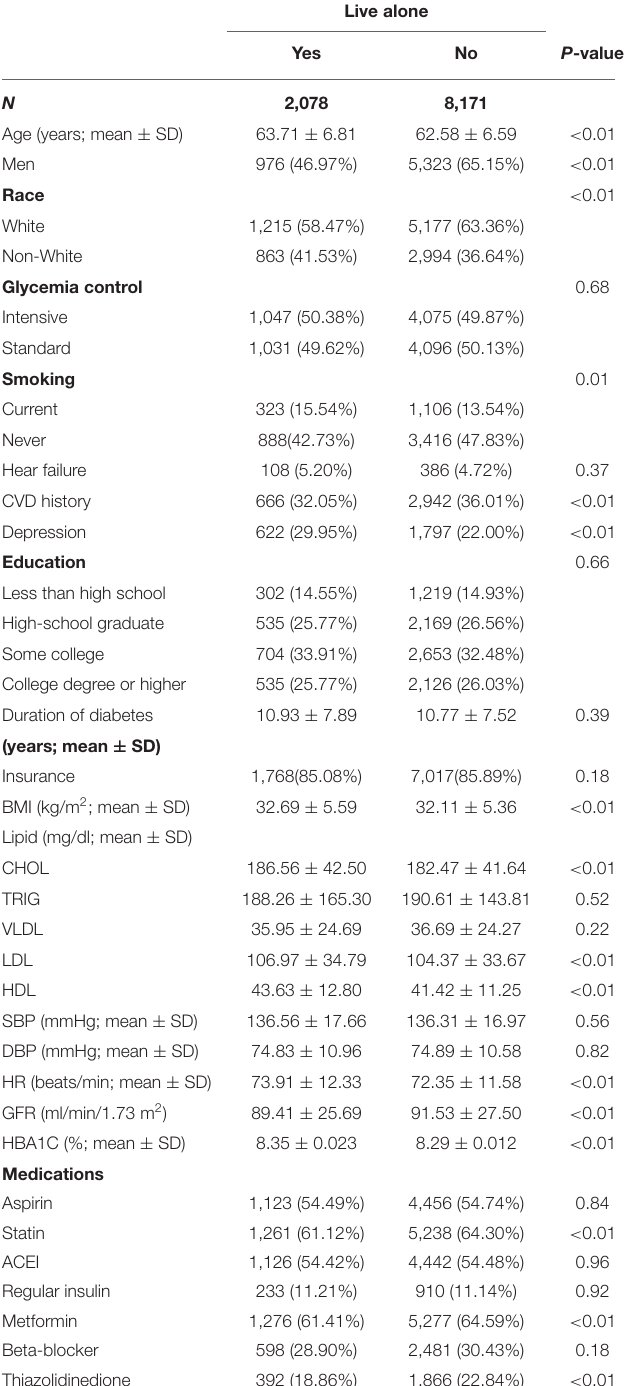
TABLE 1 | Baseline characteristics of included participants.